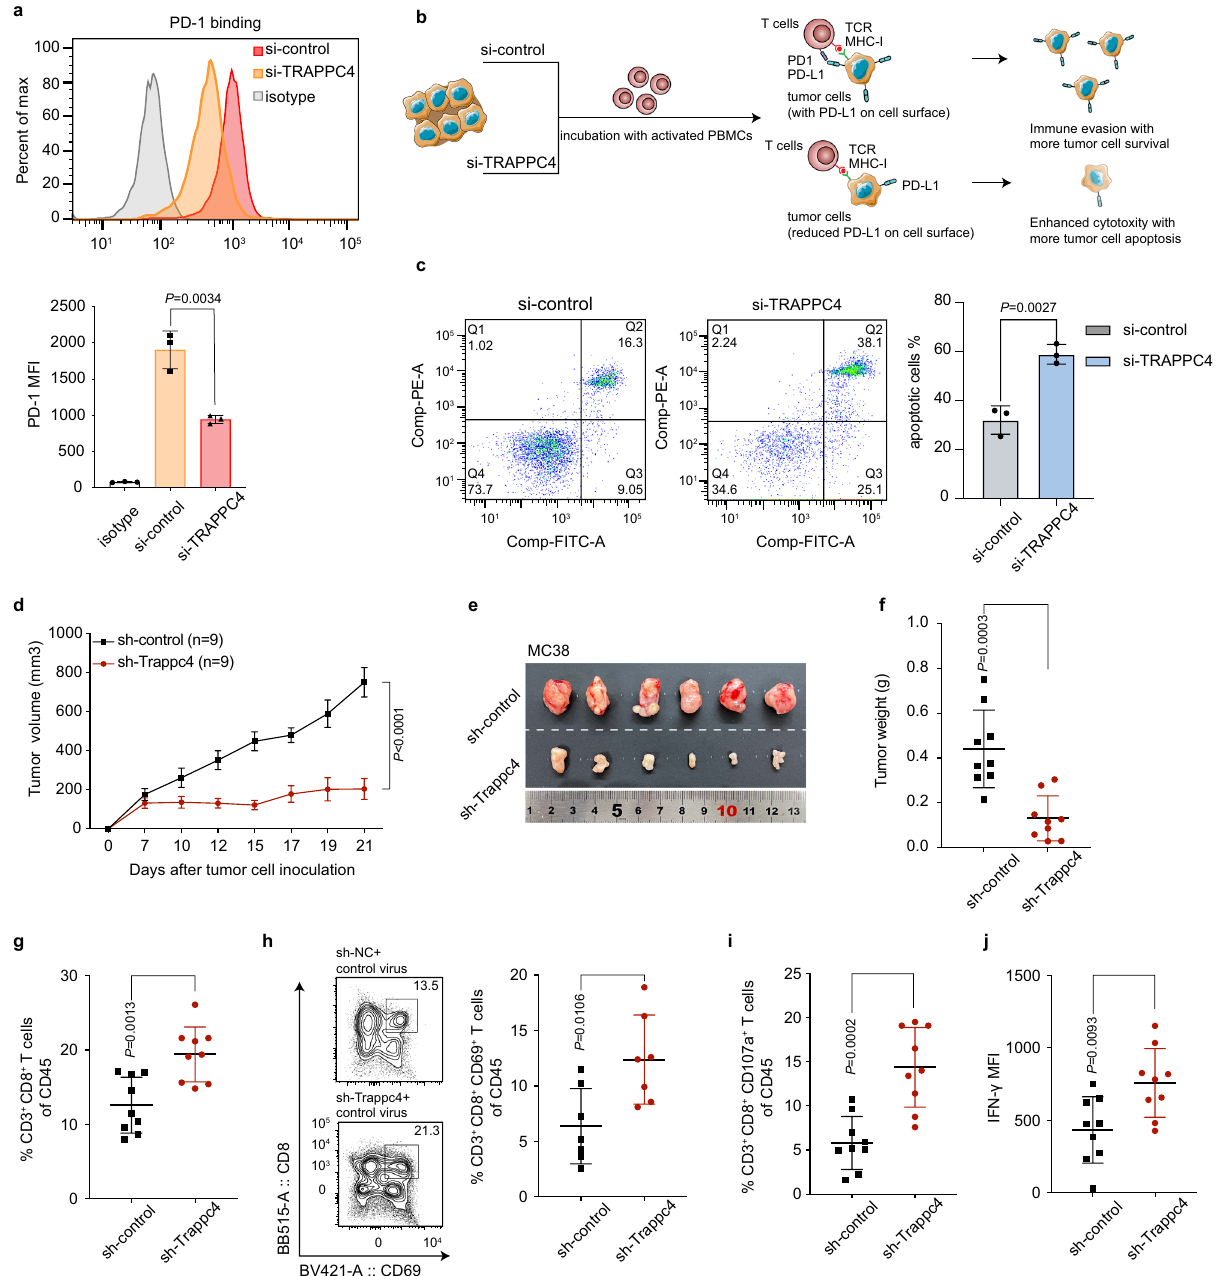
Fig. 3 The regulation of TRAPPC4 on PD-L1 affects T-cell-mediated antitumor immunity in vitro and in vivo. a Flow cytometry detection of PD-1 bound by cell surface PD-L1 on RKO cells treated with siRNAs targeting TRAPPC4 or control siRNA. The y axis indicates the MFI of fl uorescence conjugated PD-1. This fi gure represents the result of three independent experimental replicates. Values indicate means ±SD. b Schematic illustration of the experimental procedures for the T-cell-mediated cytotoxicity assay. CRC cells transfected with siRNAs targeting TRAPPC4 or control siRNA were incubated with activated PBMCs. An apoptosis assay was further conducted to determine the T-cell-mediated cytotoxicity. PBMC, peripheral blood mononuclear cell. c T-cell cytotoxicity assay against RKO cells treated with a siRNA for TRAPPC4 and control siRNA. Flow cytometry detection of apoptotic cells was conducted after co-incubation of PBMCs with CRC cells. Total apoptotic cells were de fi ned as the proportion of cells in quadrant Q2 and Q3. This experiment was performed three times independently and values indicate means ±SD. Statistical analysis was conducted using a two-sided Student ’ s t test. d – f Stable MC38 cells transduced with the indicated lentiviruses were injected into C57BL/6 mice. Statistical analysis of tumor volumes ( d ), representative images of tumors ( e ), and tumor weight ( f ) of mice in different groups ( n = 9 per group) were shown. Values indicate means ±standard error of the mean (SEM) in ( d ) and means ±SD in ( f ), compared by the two-sided Student ’ s t test. ( P = 1.3e-5 in d ). g – j The activation and function of the tumor-in fi ltrating T cells in each group were analyzed using fl ow cytometry. The percentages of CD3 + CD8 + T cells ( g ) ( n = 9 per group), CD3 + CD8 + CD69 + T cells ( h , the left panels were gated in CD45 + subsets) ( n = 7 per group), CD3 + CD8 + CD107a + T cells of CD45 + cells ( i ) ( n = 9 per group) and mean fl uorescence intensity (MFI) of IFN- γ of CD8 + T cells ( j ) ( n = 9 per group) were plotted as means ±SD compared by the two-sided Student ’ s t test. Source data are provided as a Source Data fi